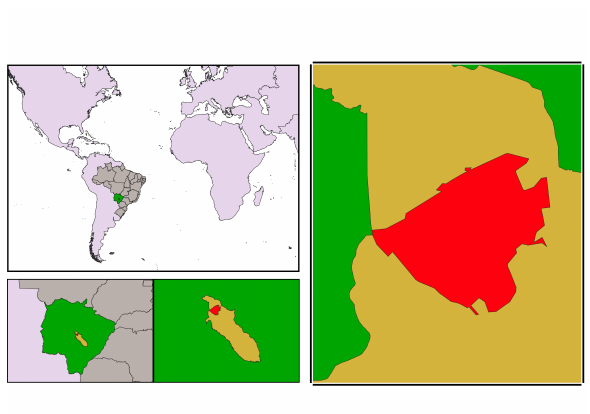
Figure 1. In the world map, we have to detach Brazil, in green, the state of Mato Grosso do Sul in dark yellow the province of Campo Grande and in red the metropolitan region of Campo Grande, where the image was obtained metation. Pynovis˜ao (dos Santos Ferreira et al., 2017), for the atributes extraction, Superpixels segmentation and classifica- tion. Api Rasterio (rasterio.readthedocs.io/en/stable), for the association between the manual image notation and the seg- mentation provided by Pynovis˜ao.